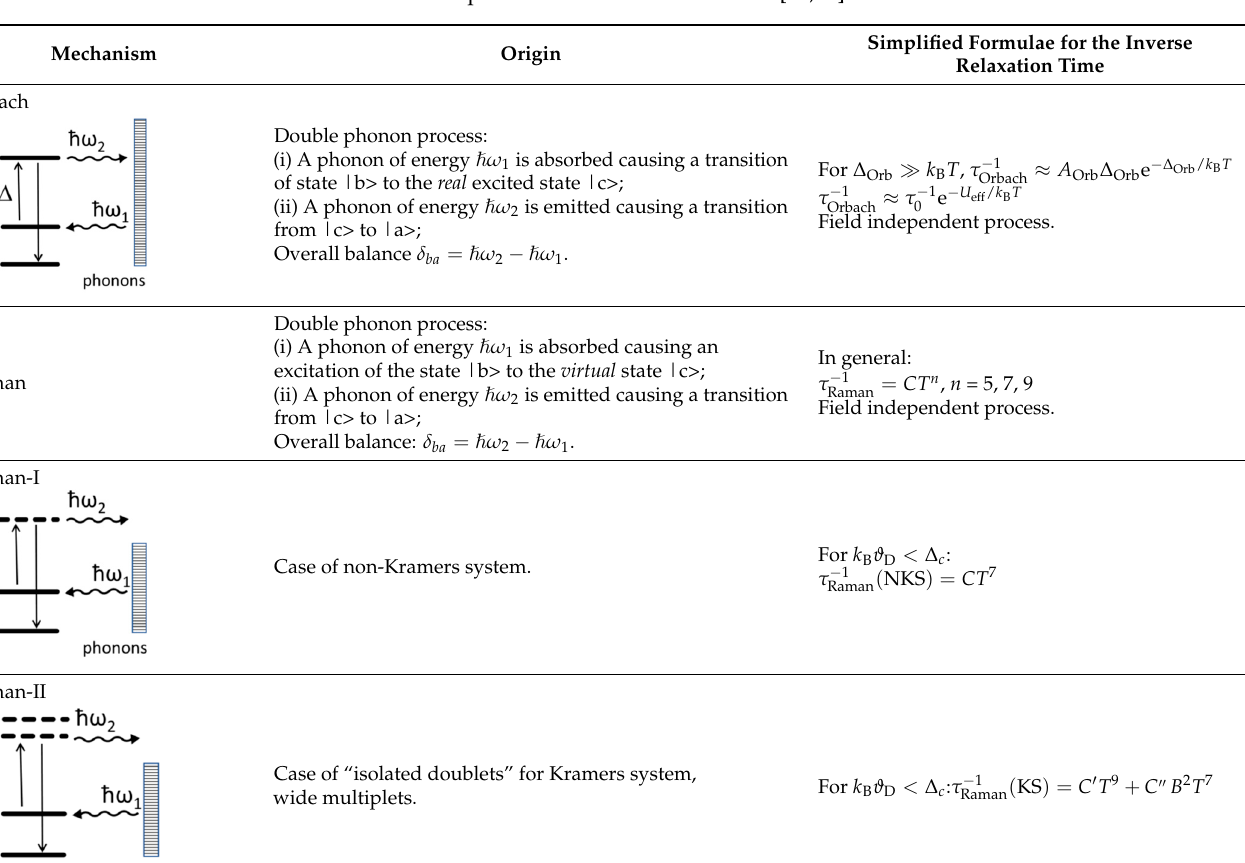
Table 1. Important relaxation mechanisms [18,19].